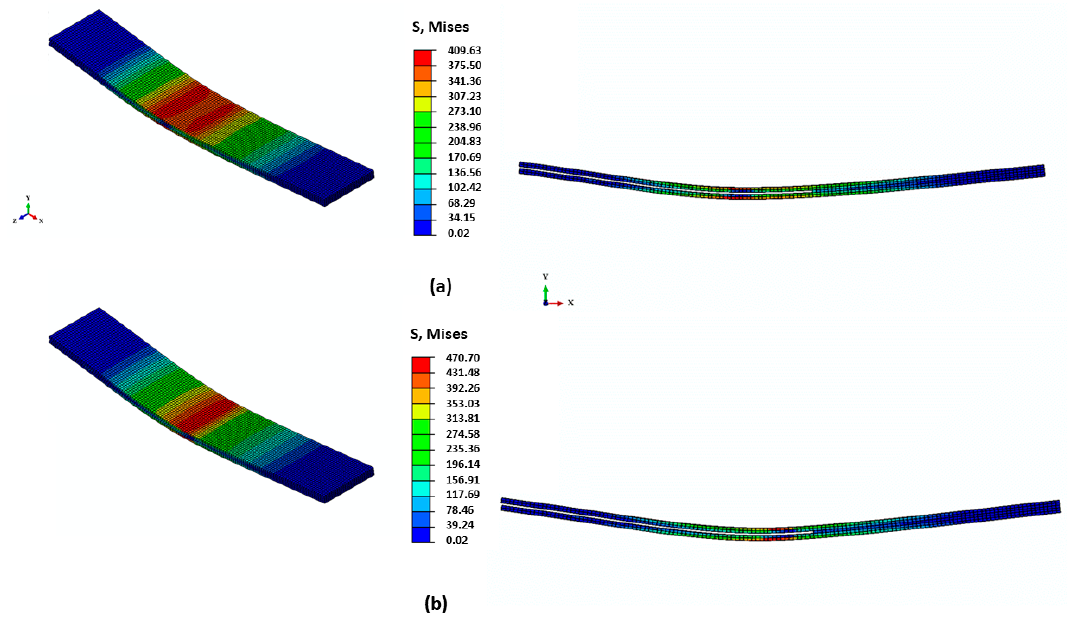
Figure 8. Stages of delamination propagation within the ENF numerical model. ( a ) Stress concentration at onset of crack propagation. ( b ) Stress distribution during degradation in traction–separation law. Note that interface is considered here as an equivalent (macro) medium, dominated by the resin along with random fiber bridges; notice the stress concentration at the crack front.